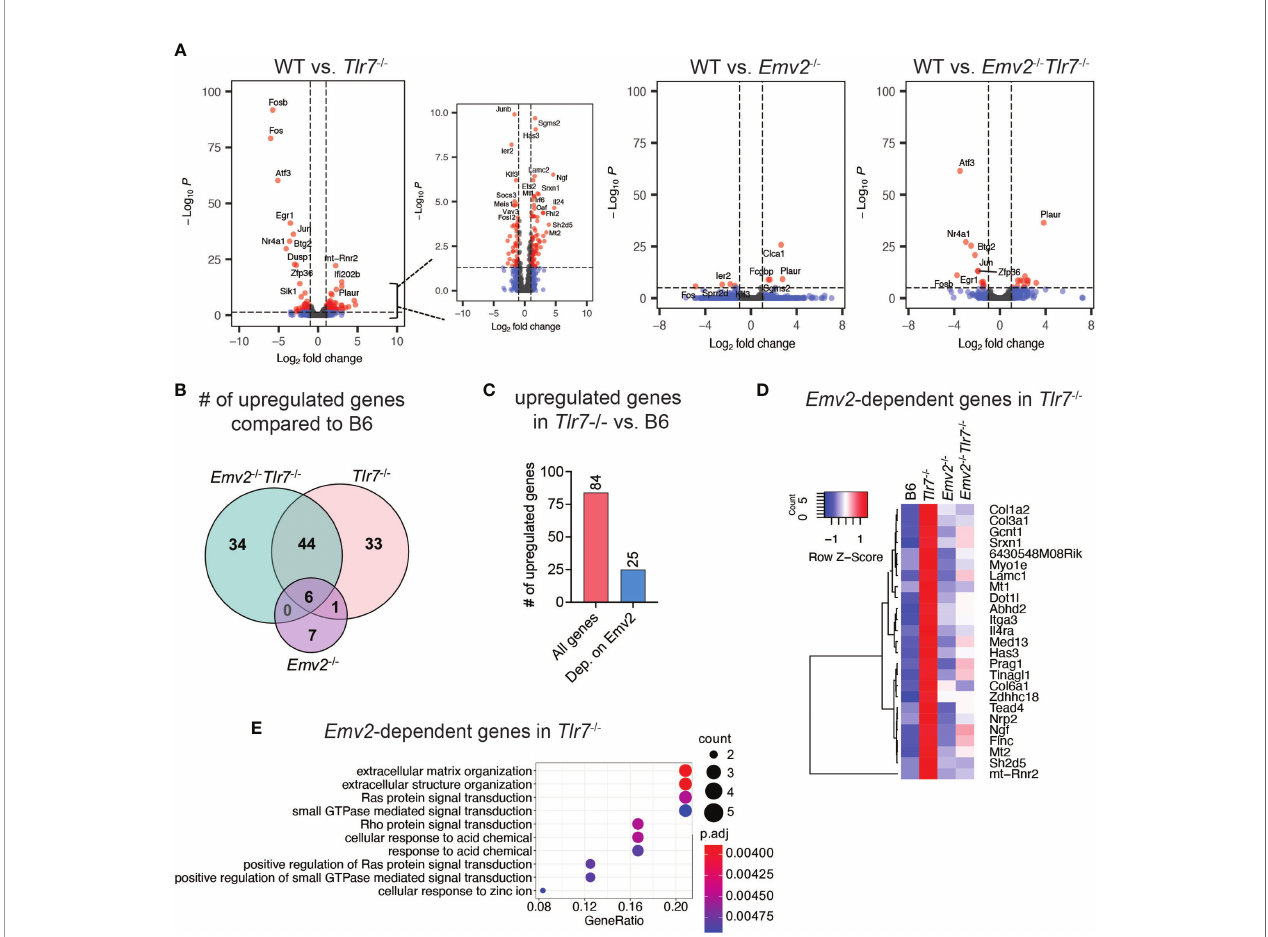
FIGURE 4 | Transcriptome analysis of HSV-2 protected vaginal tissue. (A) Volcano plots of differentially expressed cellular genes between wildtype (WT) and Tlr7 -/- , Emv2 -/- , Emv2 -/- Tlr7 -/- vaginal tissues. Log2 fold change and p-adj (log10P) values were obtained by DESeq2. (B) Venn diagram depicting the number of signi fi cantly upregulated genes (log2FC > 1; padj < 0.05) in the indicated genotypes compared to WT. (C) Number of signi fi cantly upregulated genes in Tlr7 -/- compared to WT and of those, number of genes that are not upregulated in Emv2 -/- Tlr7 -/- . Heatmap (D) and gene enrichment analysis (E) of Emv2-dependent upregulated genes in Tlr7 -/-